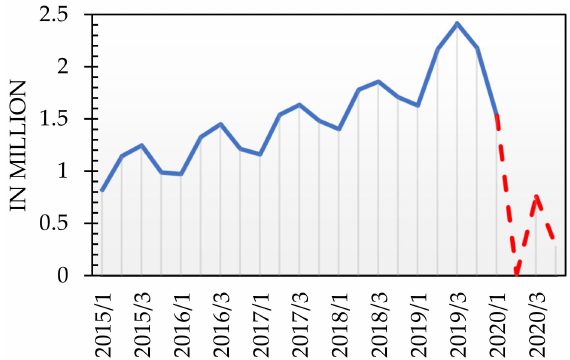
Figure 2. Number of passengers at Krak ó w Balice Airport.